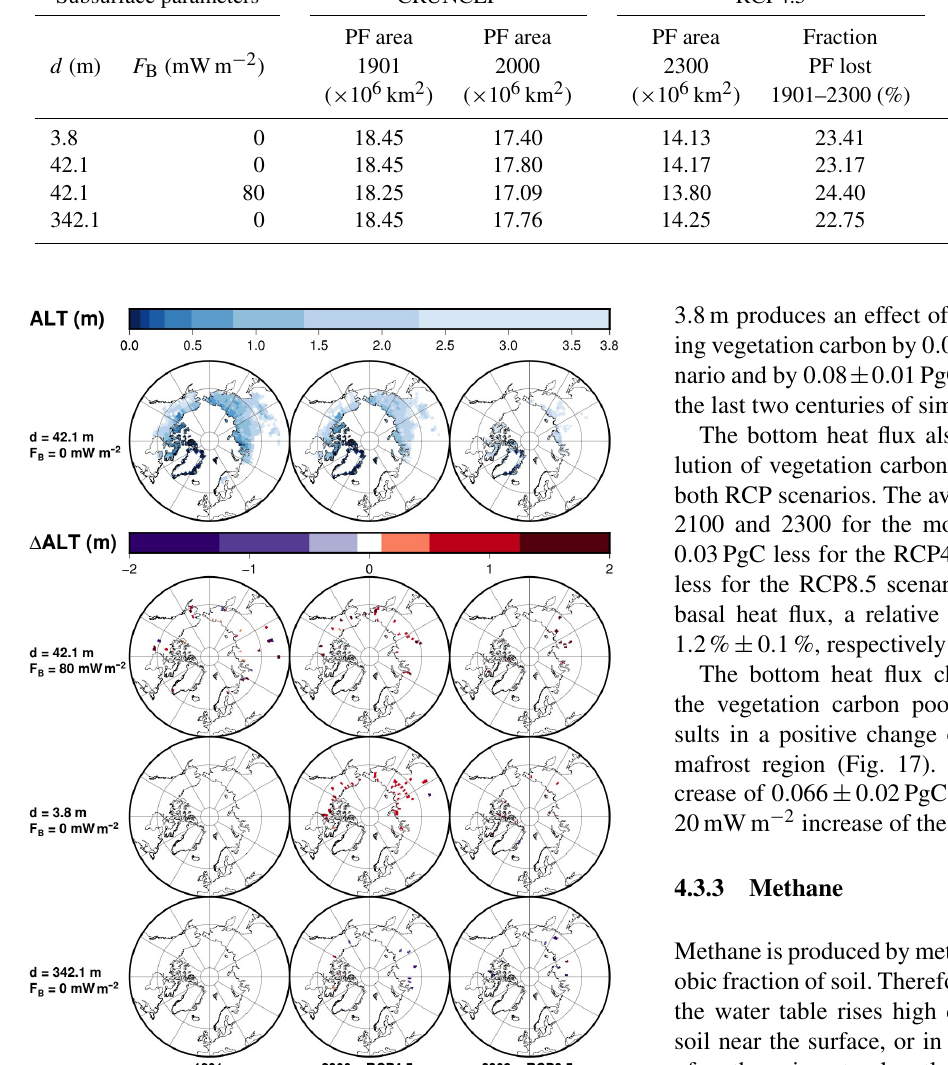
Table 4. Areal extent of near-surface permafrost at 1901, 2000 and 2300CE for the RCP4.5 and RCP8.5 scenarios. Subsurface parameters